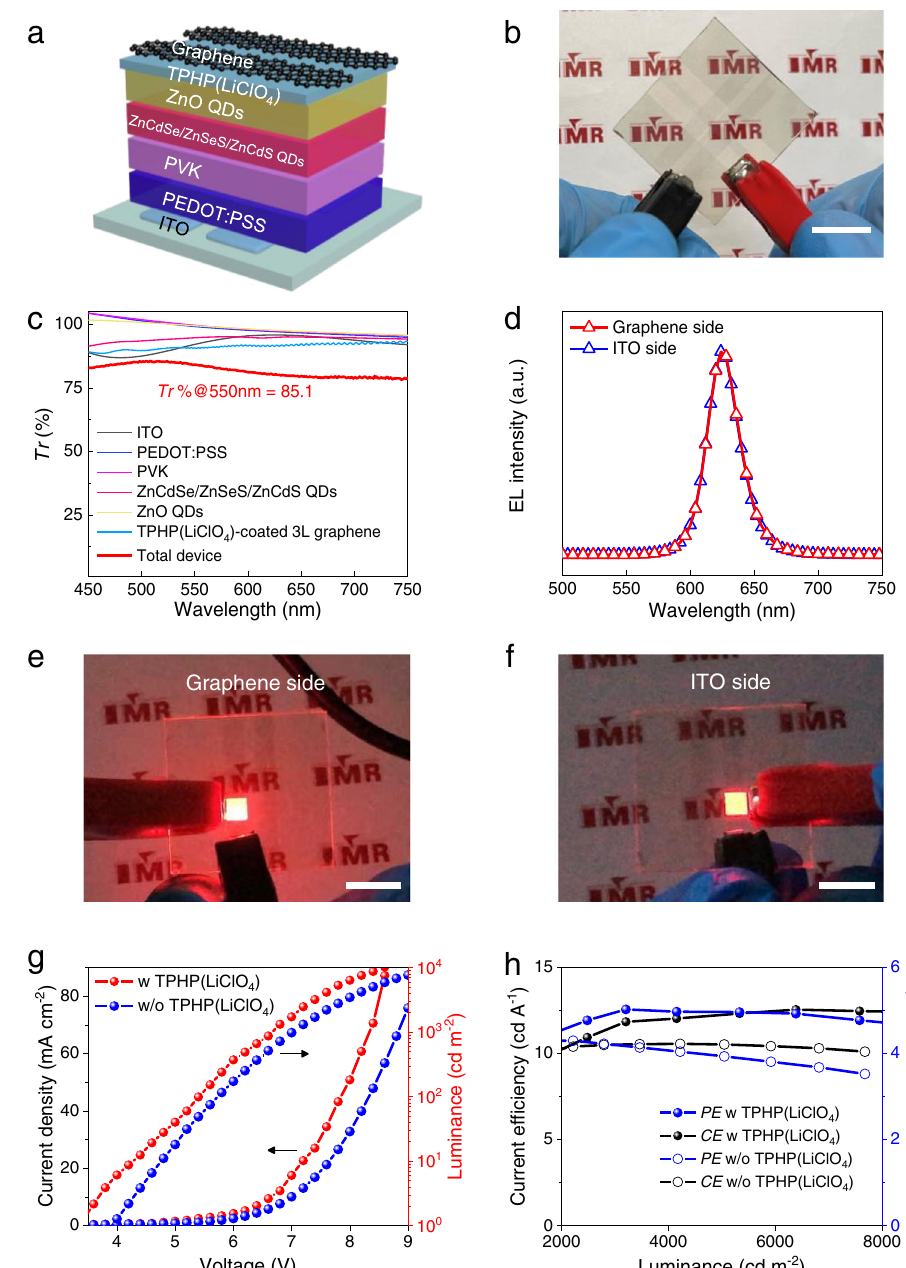
Fig.5|TransparentredQD-LEDwithgraphenetopelectrodeandTPHP(LiClO 4 ) EIL. a , b Device structure ( a ) and photograph ( b ) of QD-LED. c Tr spectra of each layer and the total QD-LED device. d EL spectra from graphene and ITO sides. e , f Photograph of a lighted QD-LED on graphene ( e ) and ITO ( f ) sides. The scale